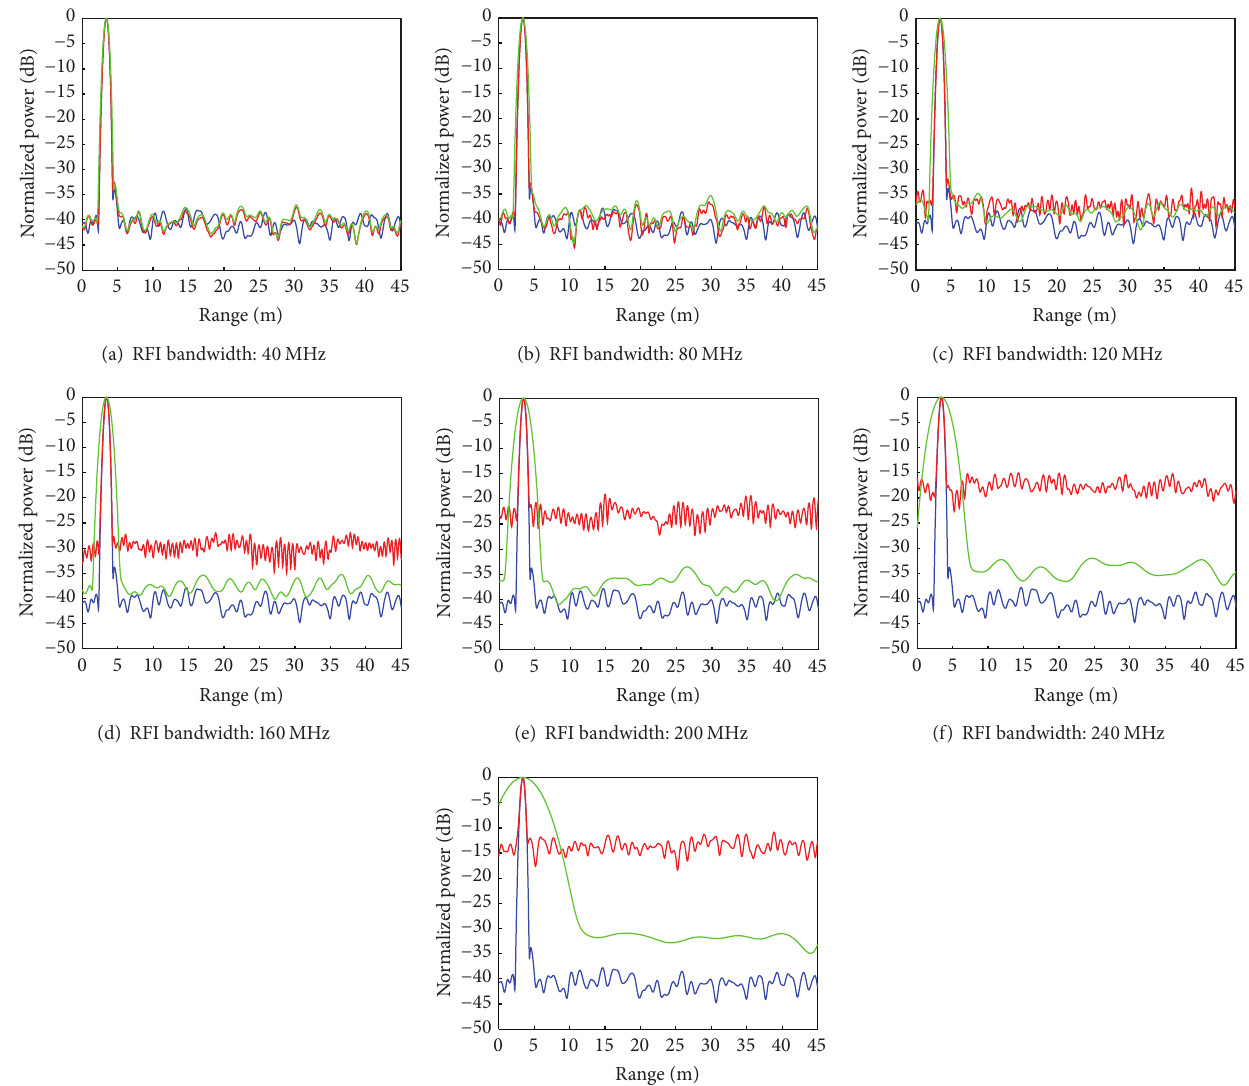
Figure 13: Range profiles for the wideband RFI experiment. As shown, the wideband RFI significantly increases sidelobe power as compared to the sidelobe power generated by the SS-MO technique (due to the reduced